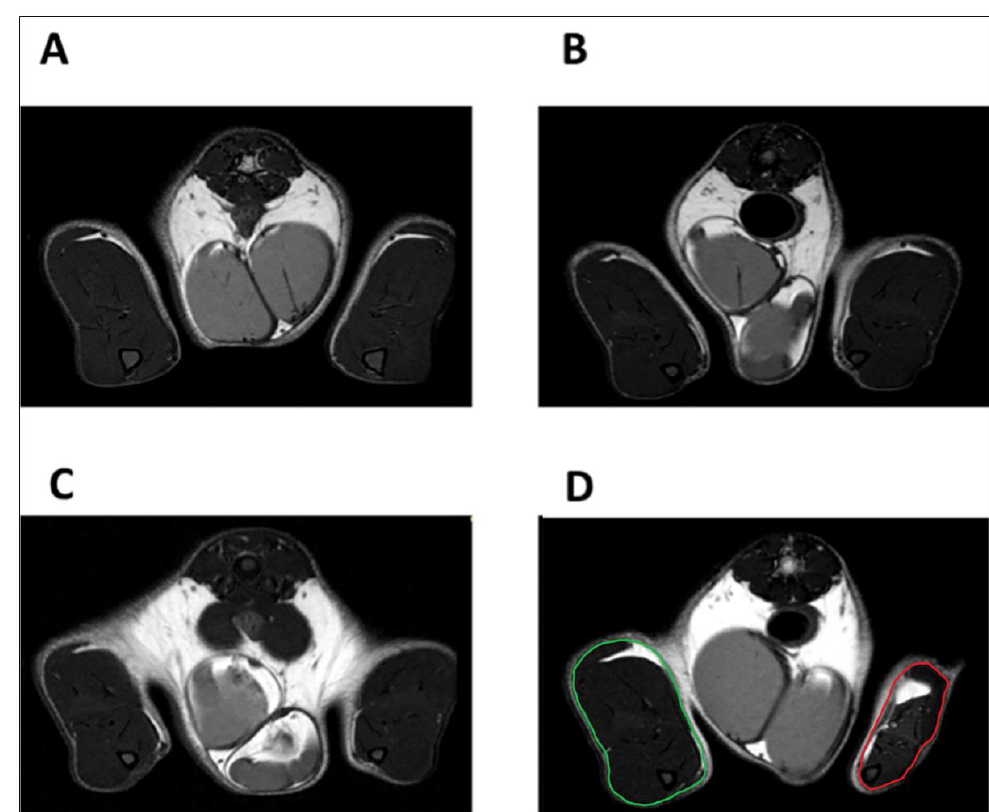
Figure 5. Representative axial T2_turboRARE weighted images with fat suppression of rat hindlimbs. Naïve rat on day 0 ( A ) and day 28 ( B ); CCI rat on day 0 ( C ) and day 28 ( D ). In Figure 5D, the red line delineates the area corresponding to the entire right paw (ipsilateral) of the CCI animal after 28 days, which was found to have a reduced volume. In contrast, the perimeter of the contralateral paw (normal volume) is delineated in green.